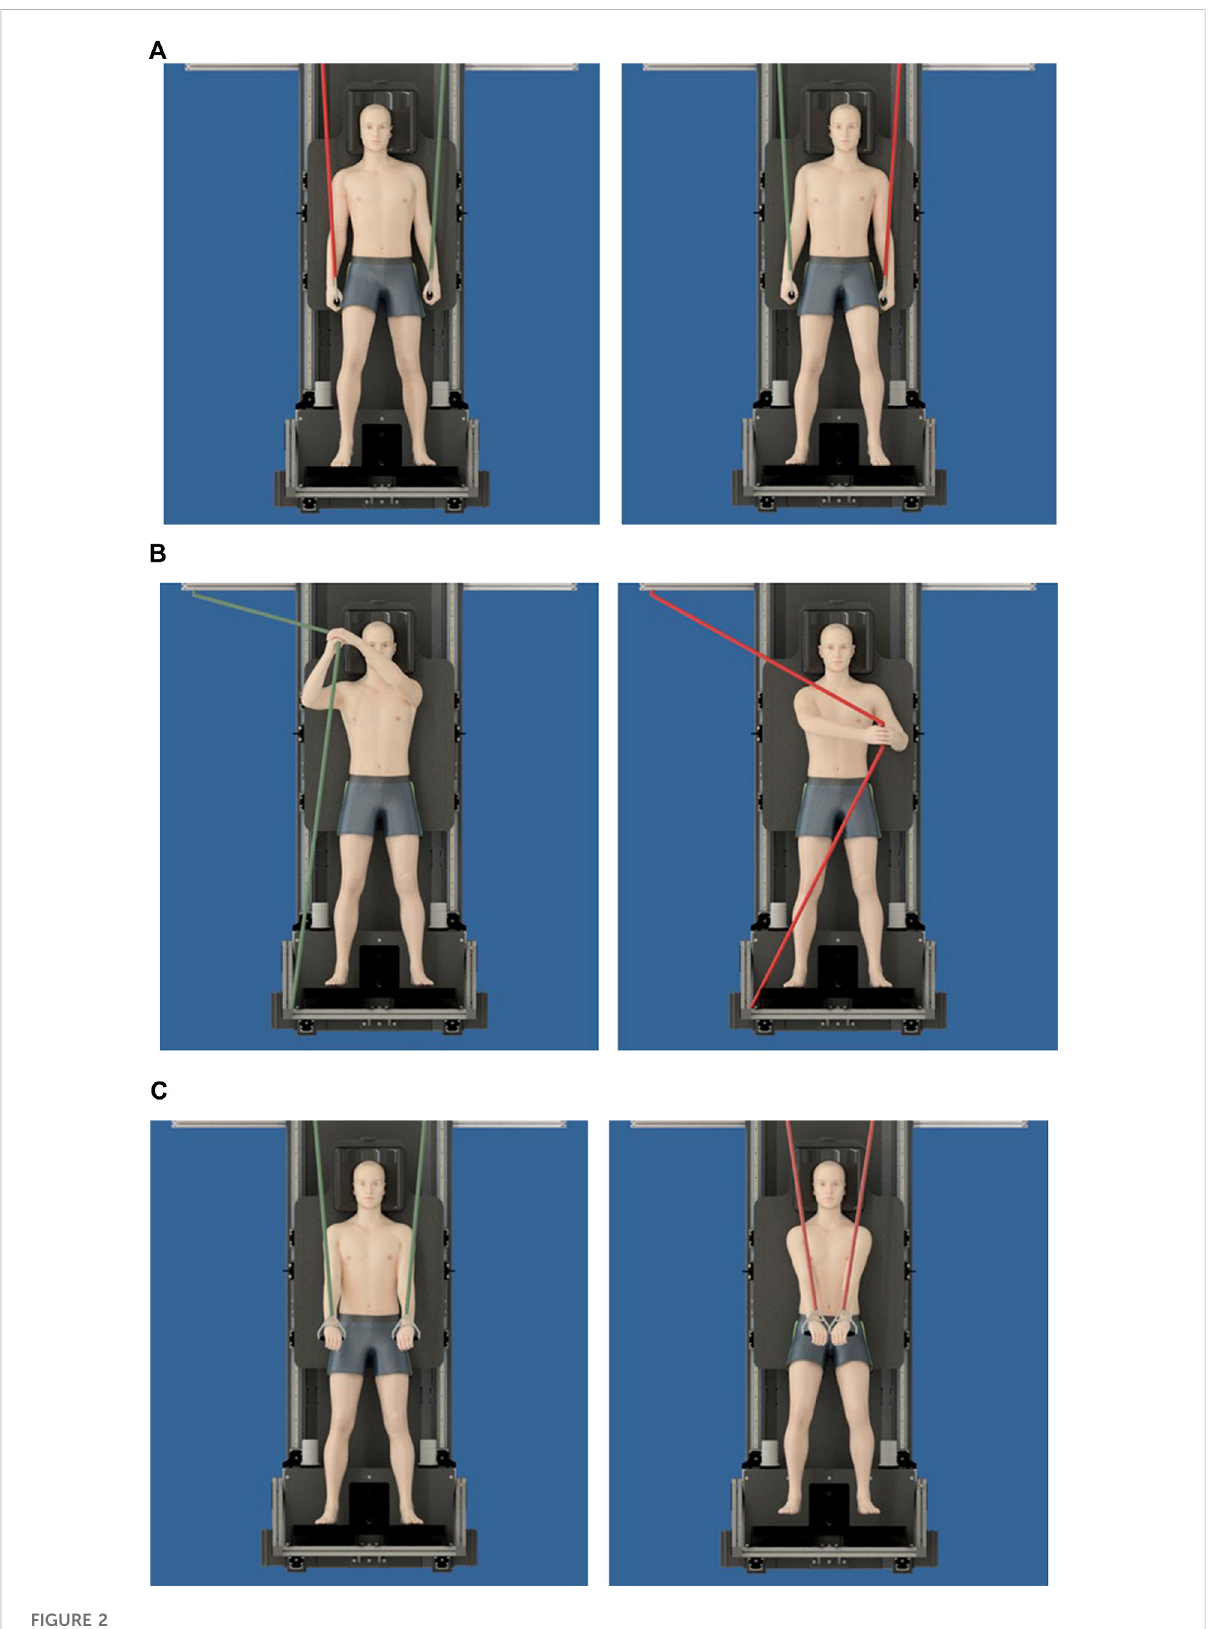
FIGURE 2 (A) Contralateral exercises per set were performed requiring participants to maintain trunk stability (straight hip) with the right arm holding suspension bands(redline)eitherwith (A) leftlegstandingonthepillowor (B) rightlegonthepillow. (B) Woodchopperexerciseswereperformedoneachsiderequiring participants to pull a rubber band (TheraBand ® ) with both arms ’ diagonal from the shoulder down towards the feet while standing on pillows. (C) Crunch Exercises were performed by pushing down suspensions with both hands simultaneously while stabilizing the trunk and standing on